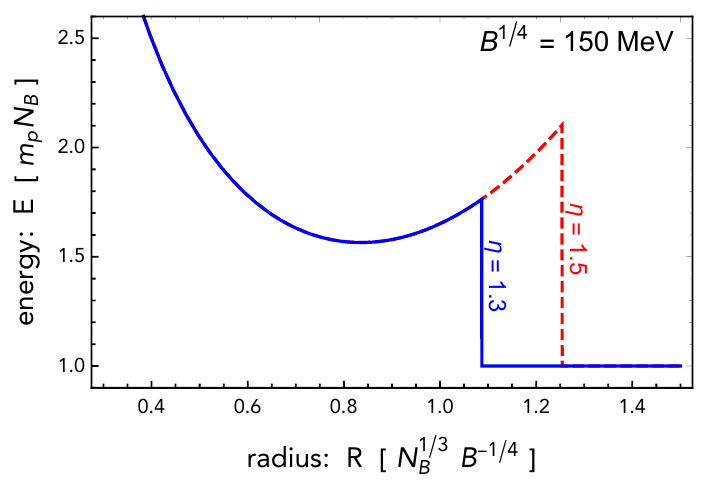
Figure 6 . A spherical region of quark matter with radius R , baryon number N B , and di(cid:11)erential pressure B has an energy E given by eq. (4.2). The local equilibrium at R min ’ 0 : 84 N 1 = 3 is unstable toward a tunneling into free hadronic matter where E (cid:25) m p N B . The barrier height depends on the critical radius R c = (cid:17)R min where the calculation breaks